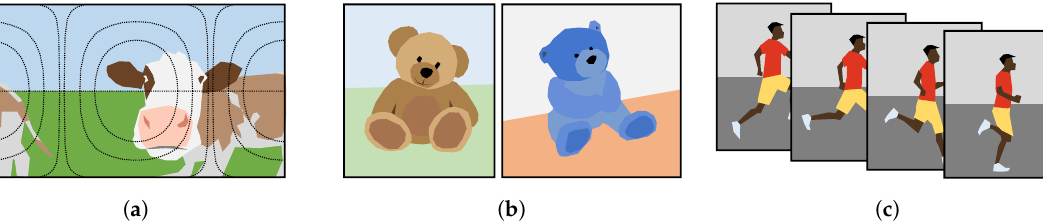
Figure 1. Visualization of the three domains of interest for visual saliency estimation: omnidirectional images ( a ), image groups for co-saliency ( b ), and clips for video saliency ( c